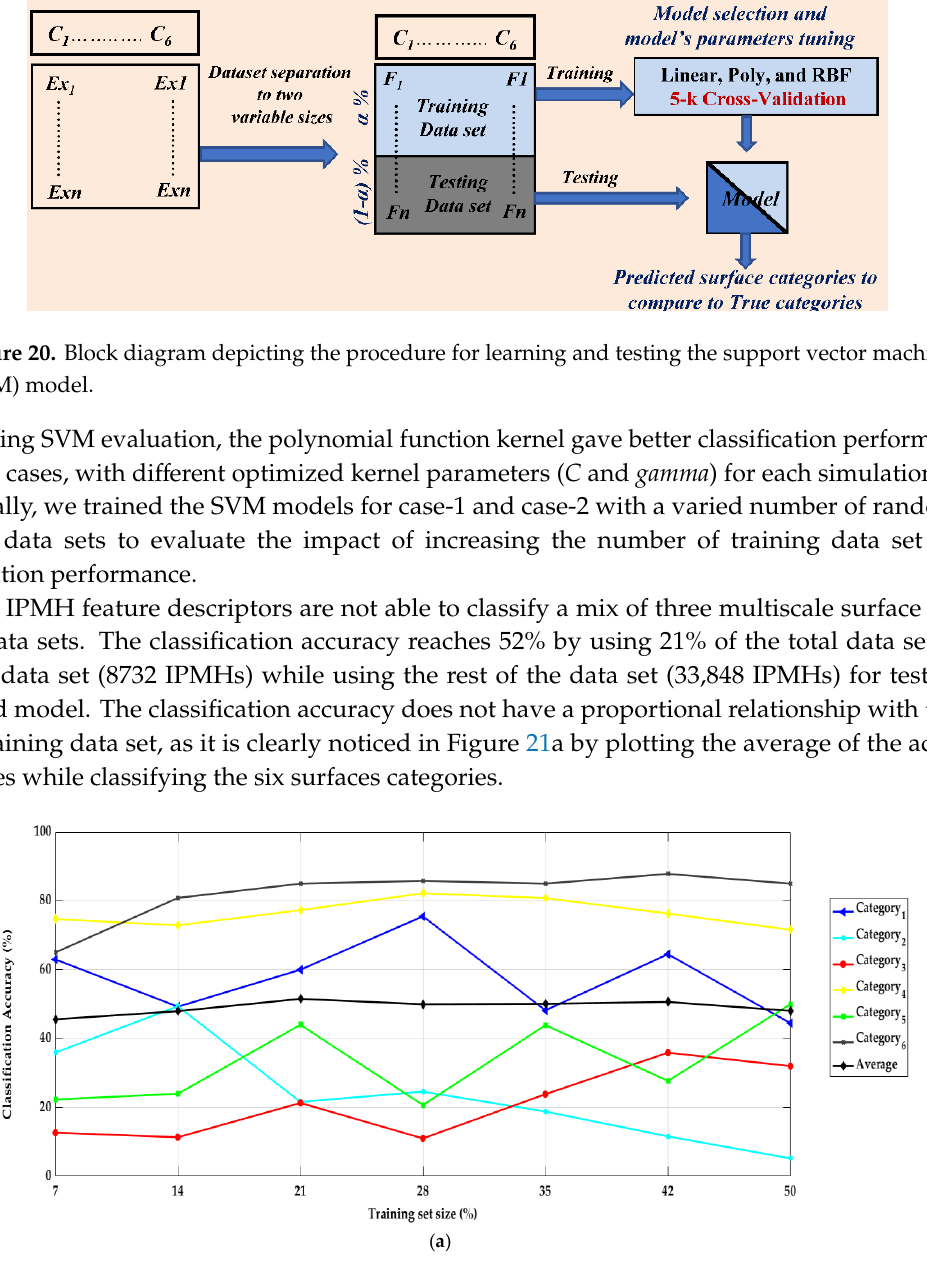
( b ) Figure 21. The topography classification performance of mixed three multiscale surface filtered image data sets: ( a ) the effect of increasing the training set size on the classification accuracy and ( b ) a confusion matrix for six surface category classifications by using 21% of the mixed data set for training. The classification accuracy is reported in the confusion matrix for the six topography categories while considering 21% of the data set for training (Figure 21b), where the columns and the rows represent the predicted and the actual classes, respectively. The values located at the diagonal of the matrix indicate the exact prediction percentage. For example, the prediction percentage for category 1 is equal to 61%. In the case of LP filtered images data set, we considered seven different percentages (from 7% to 50%) of the total data set (13,860 IPMHs) for the training data set, as illustrated in Figure 22a. The classification accuracy can reach 49% by using 42% of the LP data set (5821 IPMHs) for training. The confusion matrix (Figure 22b) presents the classification accuracy for the six categories by using 42% of the total LP filtered image data set.